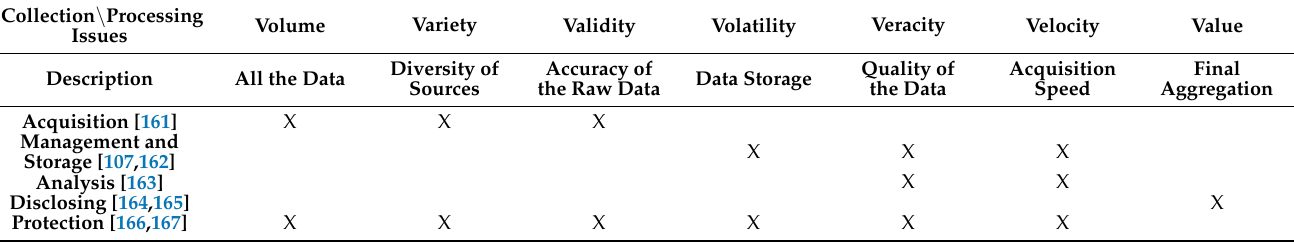
Table 7. 7Vs management in the different data